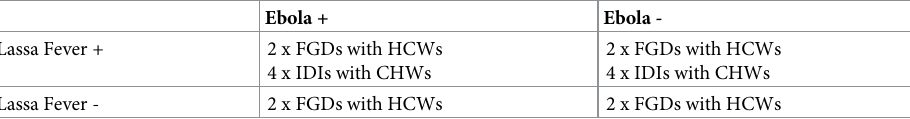
Table 1. Data collection by site type (experiences of LF and Ebola